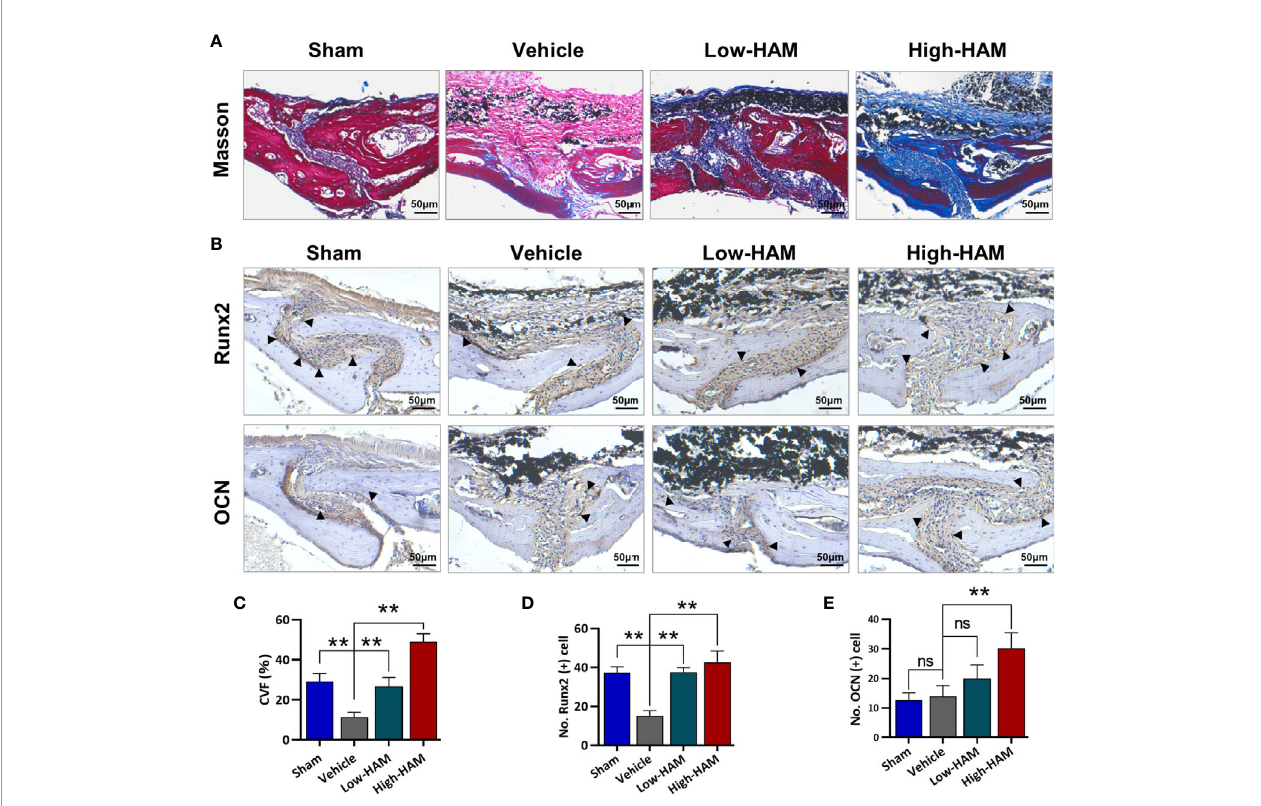
FIGURE 4 | Harmine promoted osteogenic formation in the murine PPO model. (A) Histological staining of Masson. (B) Immunohistochemical staining of Runx2 and OCN. (C) Collagen volume fraction. (D) Number of Runx2 positive cells. (E) Number of OCN positive cells. Scale bar indicates 50 m m. n = 3. All data were expressed as the mean ± SD, ns, no signi fi cance; ** p < 0.01, compared with the vehicle